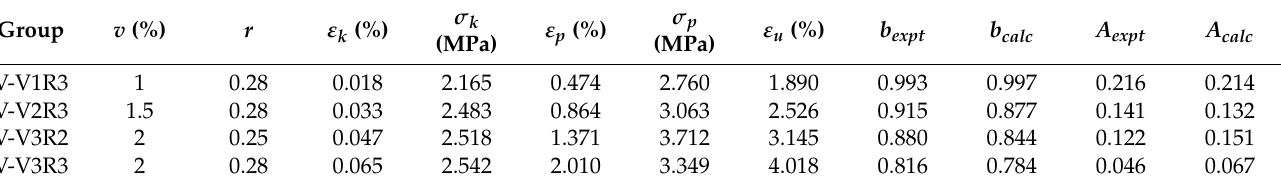
Table 5. Test results and damage model coefficients of the verification